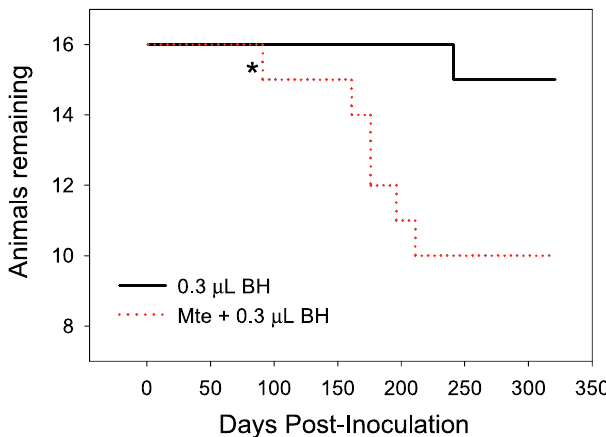
Figure 2. Mte Enhances Oral TSE Transmission at a Low Dose of Infected BH (BH–Mte Mixtures) Ingestion of Mte mixed with a lower dose of TSE-infected BH (0.3 l L) markedly shortens incubation period and increases disease penetrance relative to an equal amount of unbound BH. * indicates non-TSE intercurrent death. Animals dosed with Mte alone remained healthy throughout the course of the experiment (unpublished data).